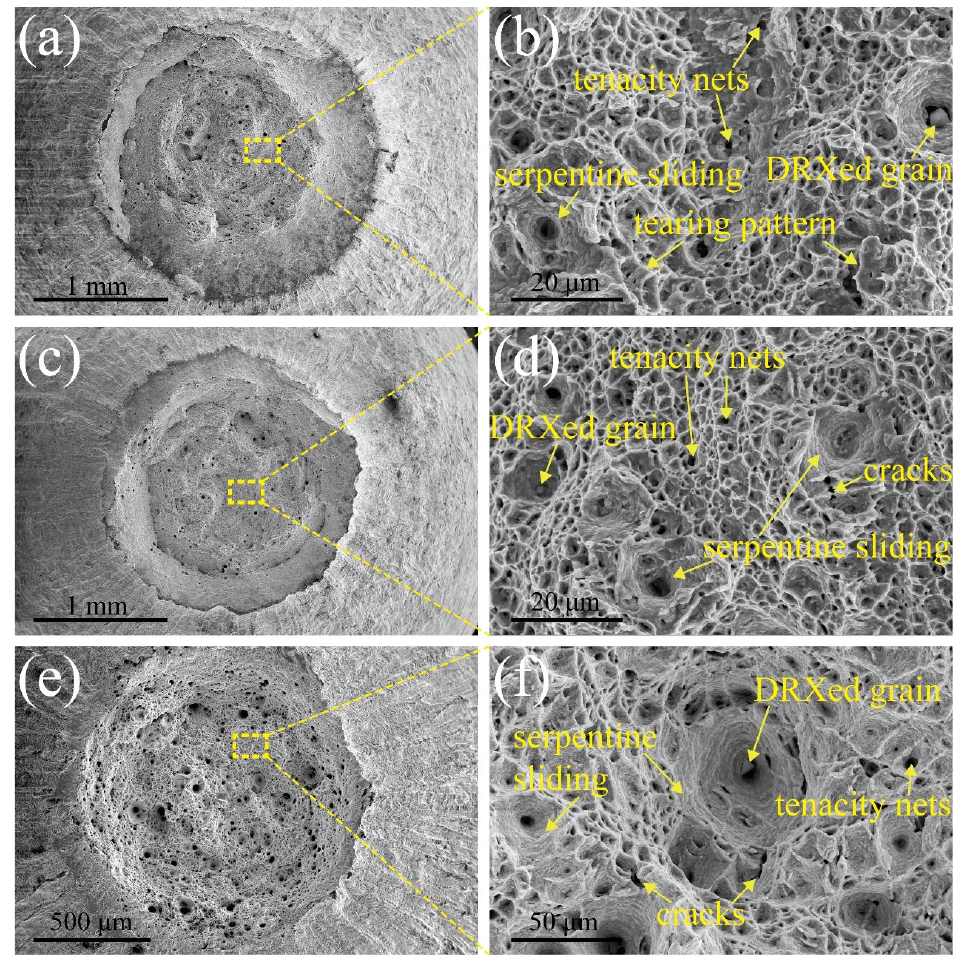
Figure 6. Fracture morphologies of tensile samples at 630 ℃ : ( a , b ) 5 × 10 − 3 s − 1 ; ( c , d ) 5 × 10 − 4 s − 1 ; ( e , f ) 5 × 10 − 5 s − 1 .